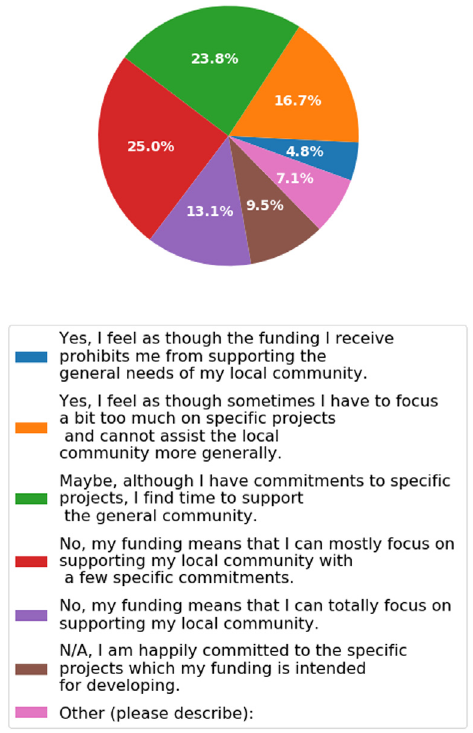
Figure 13. Bar chart representing answers to Q2.9. Participants were able to select only one answer. Data was pooled from across job descriptions for this question.